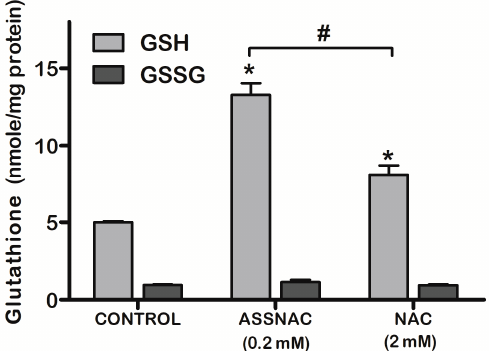
Figure 3. Effect of ASSNAC and N -acetyl-cysteine (NAC) on glutathione (reduced (GSH) and oxidized (GSSG)) level in ARPE-19 cells. Confluent ARPE-19 cells were incubated without (control) or with ASSNAC (0.2 mM) or NAC (2.0 mM) for 24 h. Glutathione was extracted and GSH and GSSG cellular contents were determined. GSH content in the ASSNAC and NAC treated groups was significantly higher than in the control (* p ≤ 0.01) and significantly higher in ASSNAC than NAC treated group (# p ≤ 0.01).